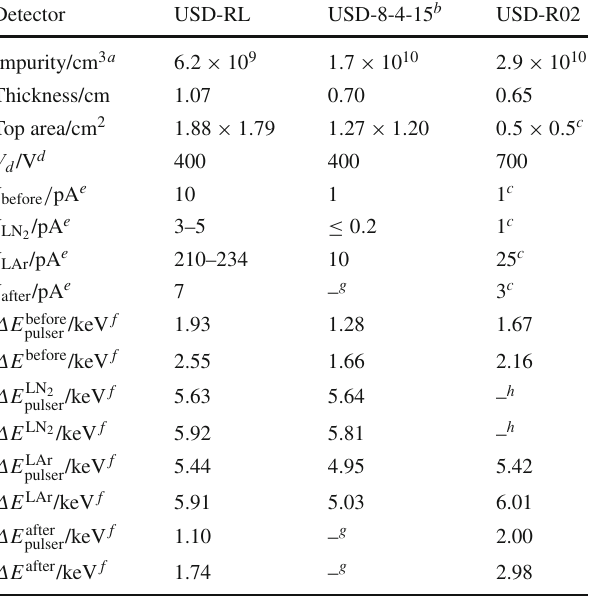
Table 1 Summary of USD detector properties